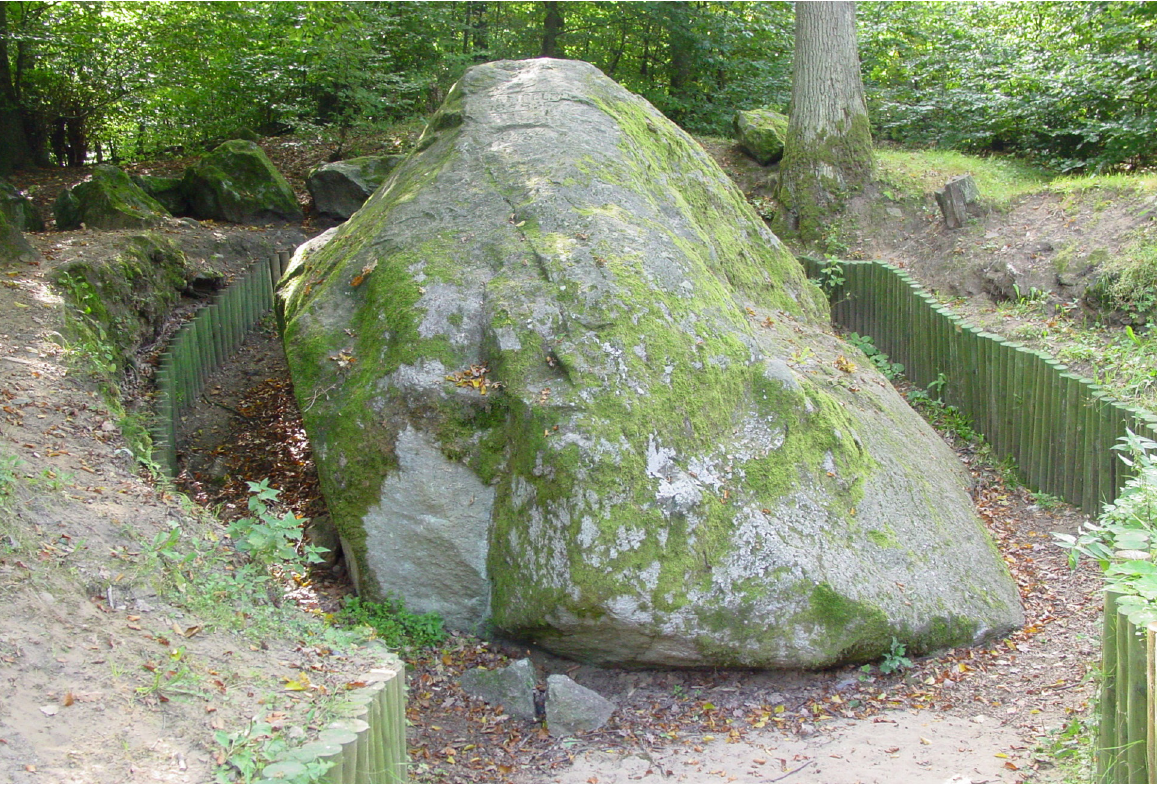
Fig. 5. “tempelburg” boulder is the biggest inanimate monument located in the vicinity of the planned geopark (phot. M. Górska-Zabielska,